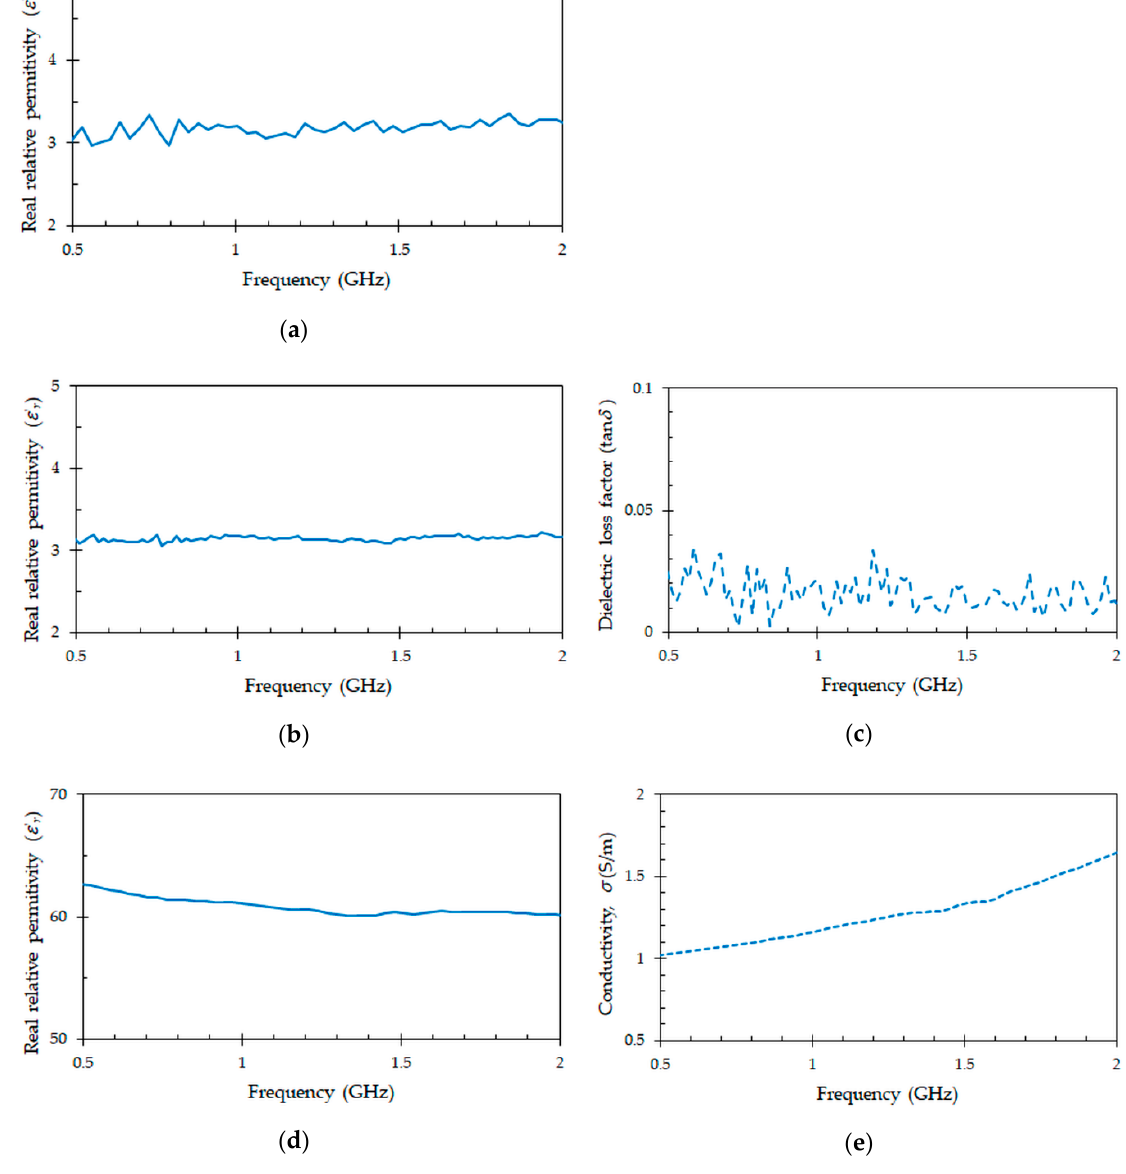
Figure 1. Measured electrical parameters of the materials involved in the tag design: ( a ) Real part of the relative permittivity for Kapton polyimide; ( b ) real part of the relative permittivity for polyethylene terephthalate (PET) tube; ( c ) Dielectric loss tangent for PET tube; and ( d ) real part of the relative permittivity for blood; ( e ) conductivity for blood.